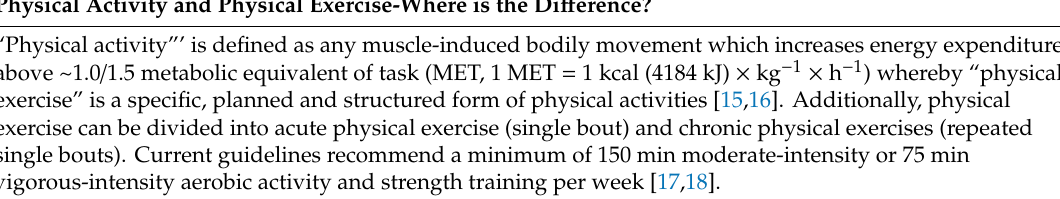
Table 1. Physical activity and physical